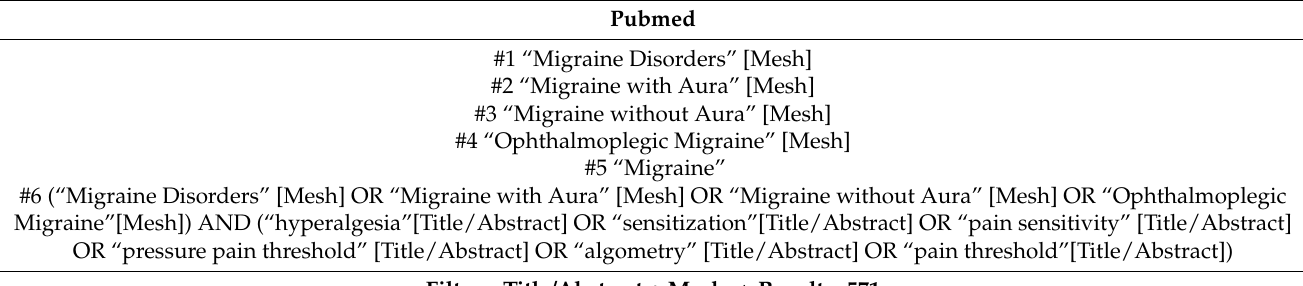
Table 2. Search Strategy for Migraine